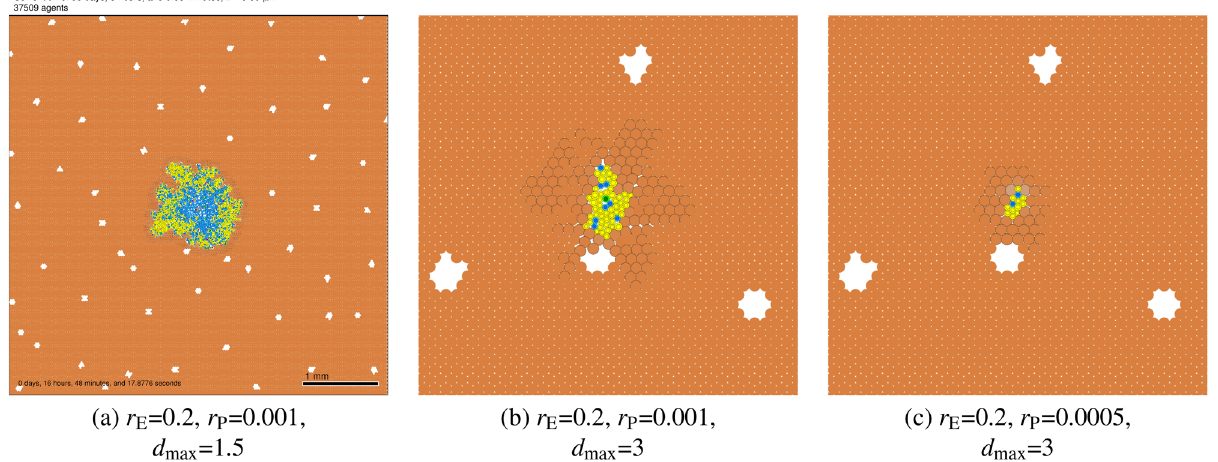
Figure 9. Dormant micrometastases: Metastatic growth into highly elastic parenchyma with high tolerance for deformation can lead to tumor encapsulation. If plastic relaxation is slow, mechanical feedbacks are sustained, leading to slow (but potentially invasive) growth ( a ) or tumor dormancy ( b , c ). Cells are colored as described in Fig. 5.